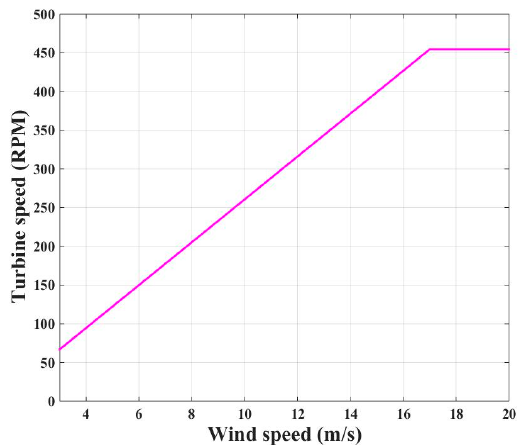
Figure 4. Optimal turbine speed versus wind speed.